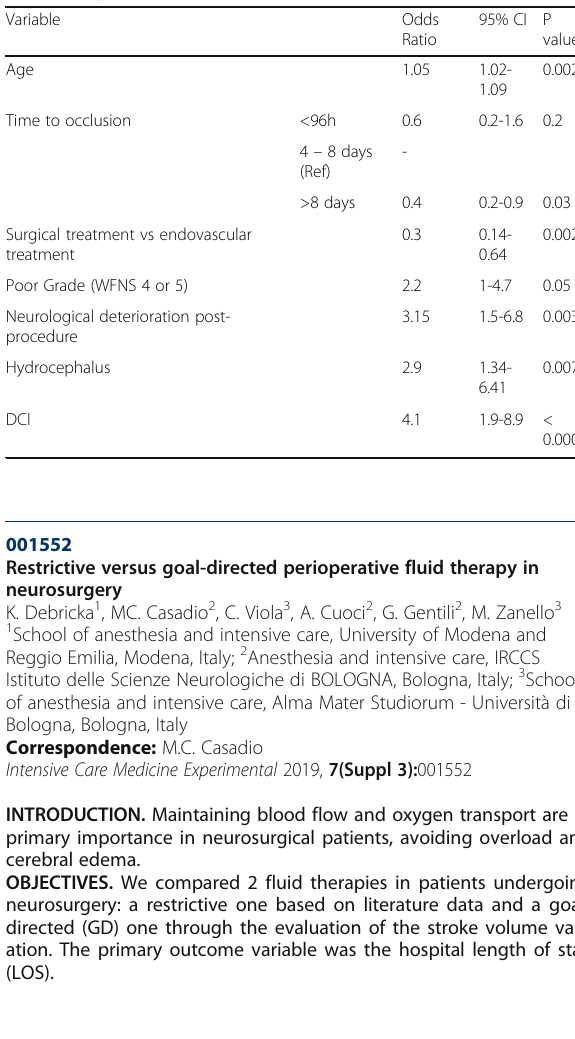
Table 1 (abstract 001537). Association of studied variables and mortality – Multivariate